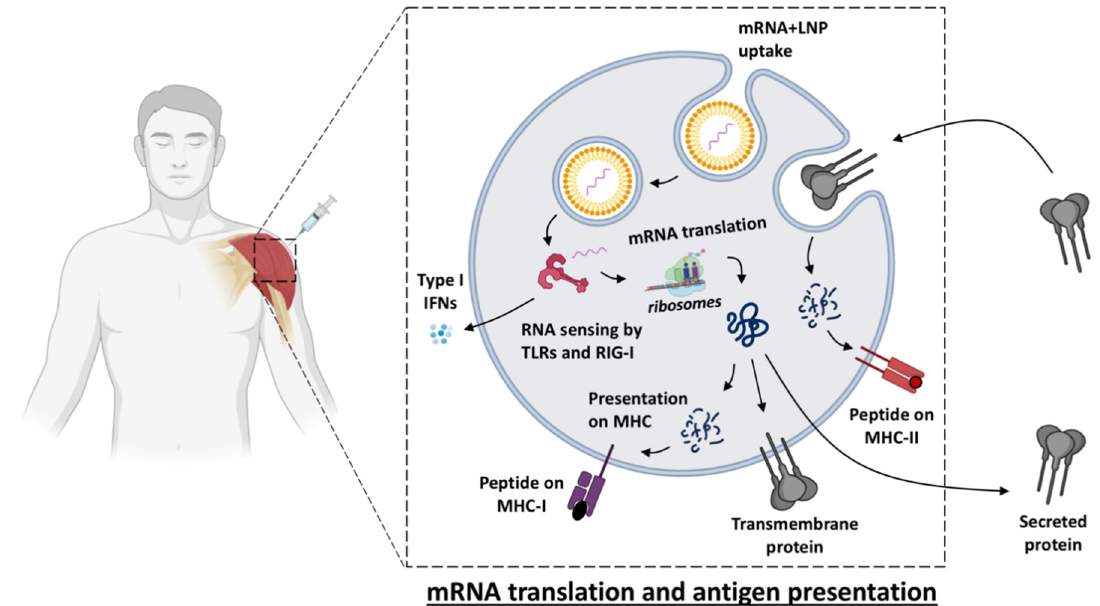
Figure 1. Simplified overview of the events that follow uptake of an LNP-formulated mRNA vaccine by a cell. Once the mRNA molecule is released from the LNP into the cytosol, it is sensed by toll-like receptors (TLR), e.g., TLR3 or 7/8 and by retinoic acid-inducible gene (RIG)-I, which promotes secretion of type I interferons (IFNs) to the extracellular matrix that will create a milieu that favors Th1 responses over Th2. mRNA is directly translated by ribosomes into polypeptides which are processed by the proteasome system, leading to peptide presentation onto MHC-I on the cell surface (similarly as during a viral infection), and post-translationally modified to be folded into the protein which, depending on the mRNA design, can either be membrane-anchored or be secreted. Peptide presentation onto MHC-II may occur on APCs after protein uptake of extracellular proteins or of cell debris containing protein. This figure was created using BioRender.com.